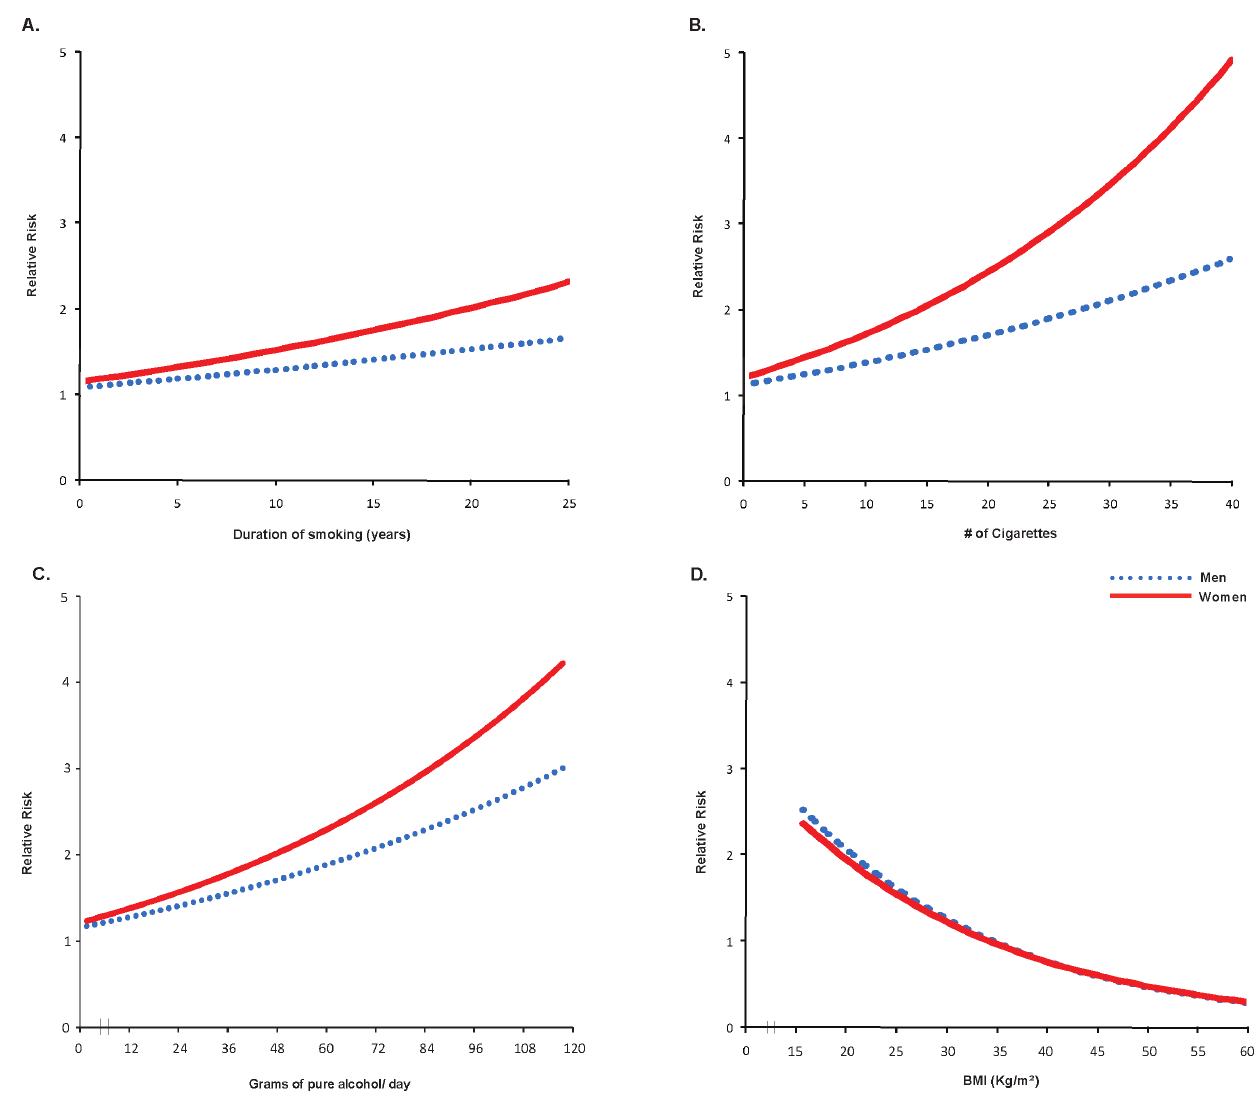
Figure 1. Dose-response relationships of (A) duration of smoking, (B) quantity of smoking, (C) quantity of alcohol consumption, and (D) BMI with self-reported symptoms of active TB disease by gender.